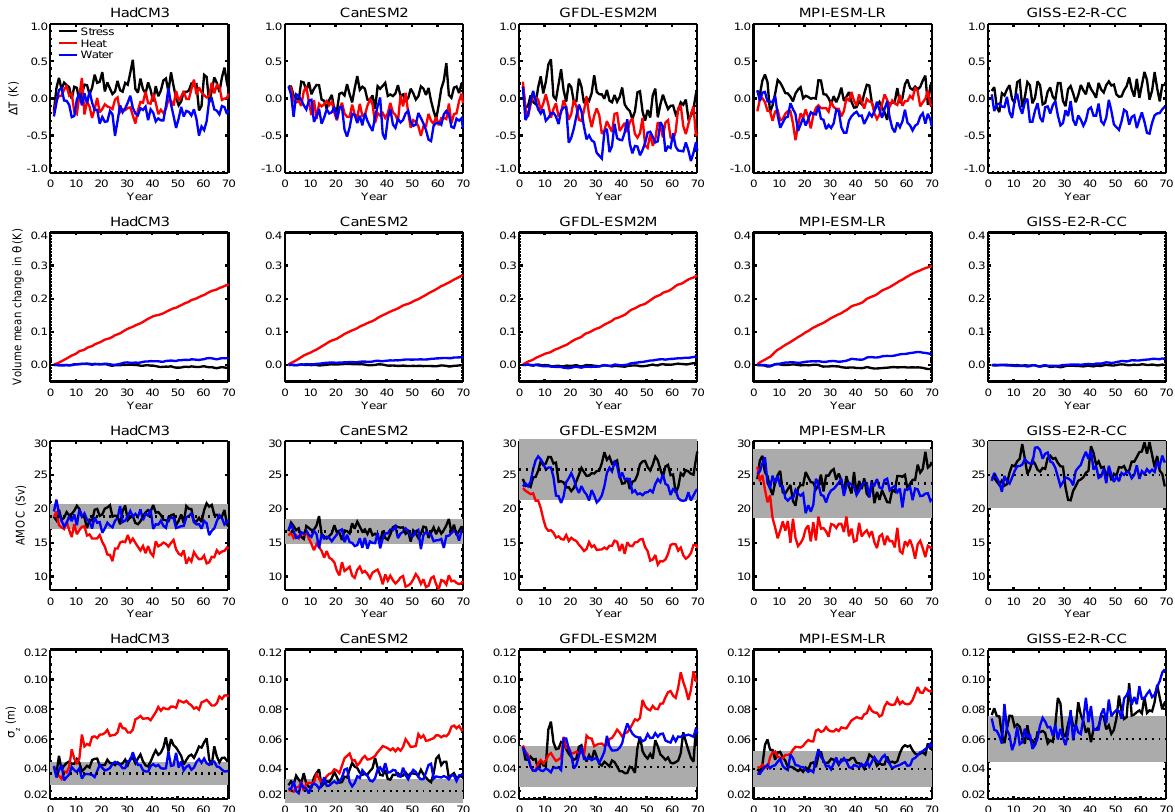
Figure 5. Annual time series in faf-stress, faf-heat and faf-water, according to the key in the first panel. Top row, global-mean surface air temperature change (K) with respect to the control time mean; second row, ocean volume-mean temperature change (K) with respect to the corresponding year of the control; third row, maximum of the Atlantic meridional overturning streamfunction (Sv); bottom row: σ ζ (m), the spatial standard deviation of (cid:49)ζ , the dynamic sea-level change relative to the 70-year time mean in the control experiment. For the AMOC and (cid:49)ζ , the grey band indicates the range of values which do not differ significantly (as defined in the text) from the control time mean, which is indicated by the dotted